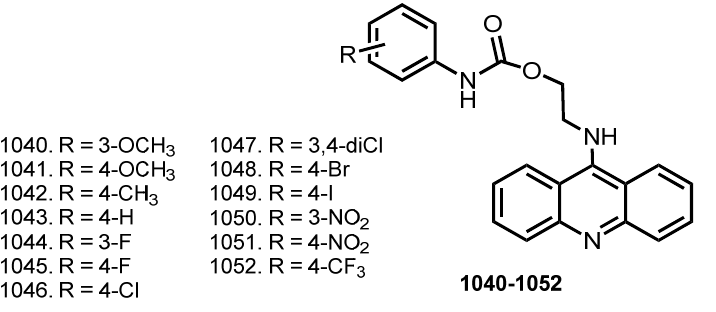
Figure 38. THA–carbamate hybrids 1040 – 1052 [132].